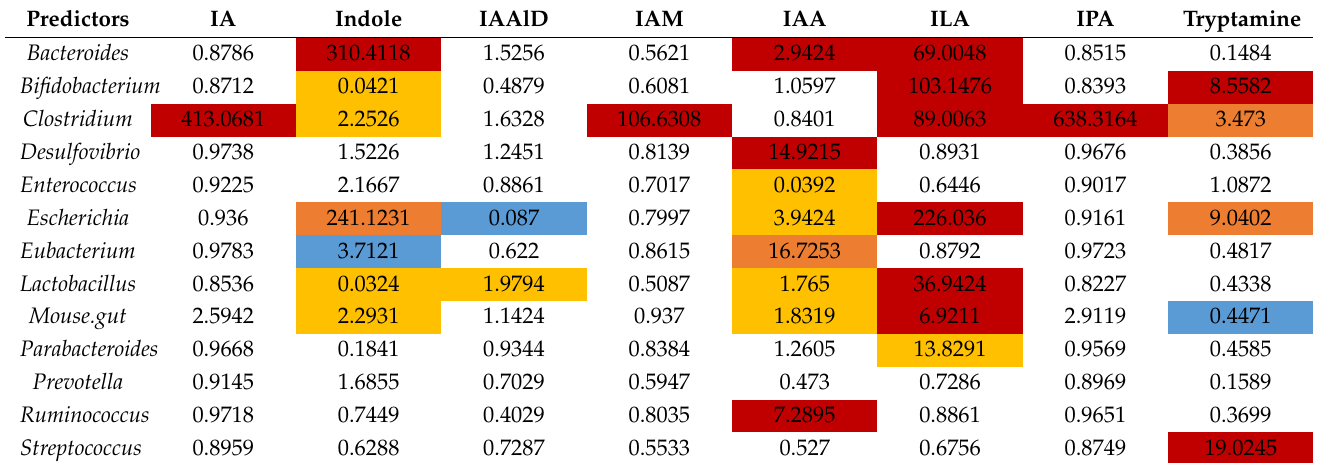
Table 1. Odds ratio of dominate genera in mouse gut for bioactive indole generation (red: